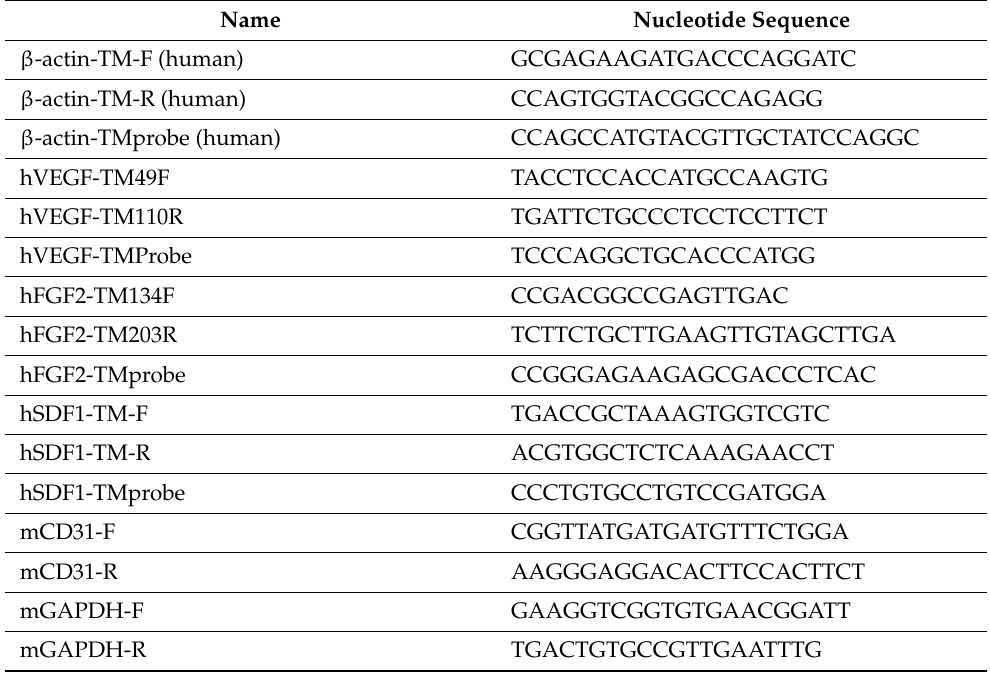
Table 2. Nucleotide sequences of primers used for